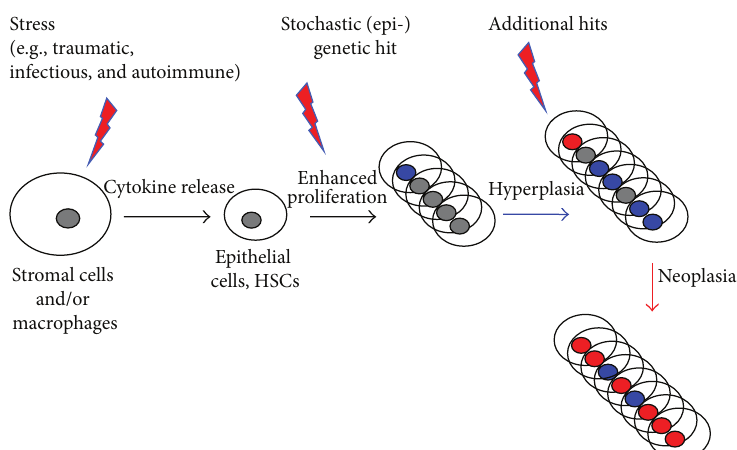
Figure 1: Multistep process for inflammatory driven neoplastic transformation. Stress, induced by various intrinsic and extrinsic factors, causes epithelial cells as well as stromal macrophages to release cytokines and other proliferation-promoting molecules, which lead to enhanced proliferation of surrounding cells. In a second step, enhanced proliferation increases the chance of stochastic mutations, leading first to hyperplasia and subsequently, with the accumulation of additional aberrations, to